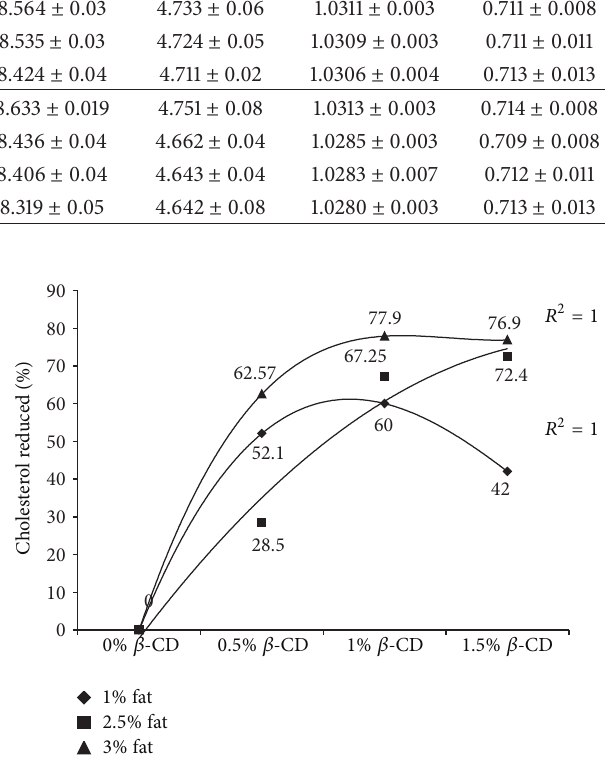
Figure 4: Cholesterol reduction (percentage) by various concentra- tions of 𝛽 -CD in milk with different fat